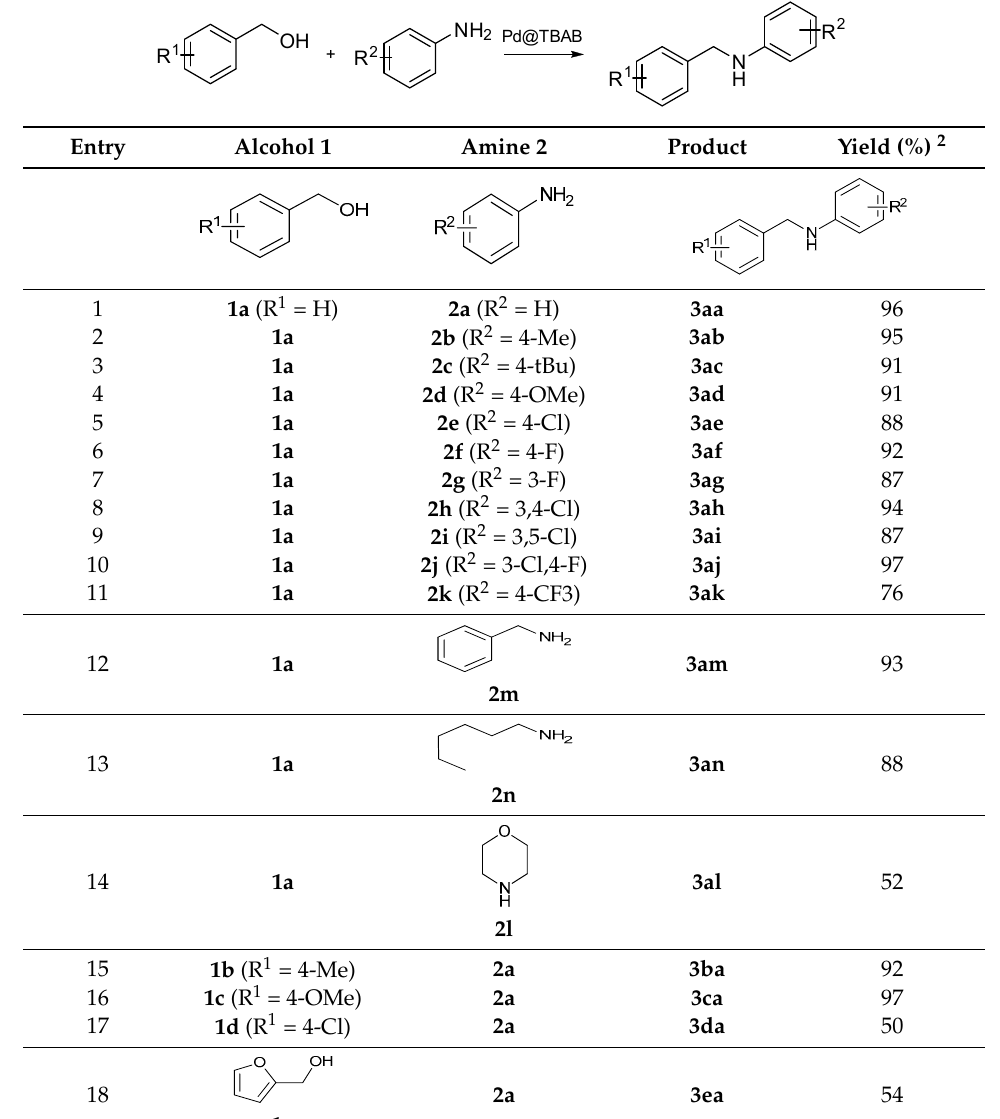
Table 2. N- alkylation of amines with alcohols 1 .